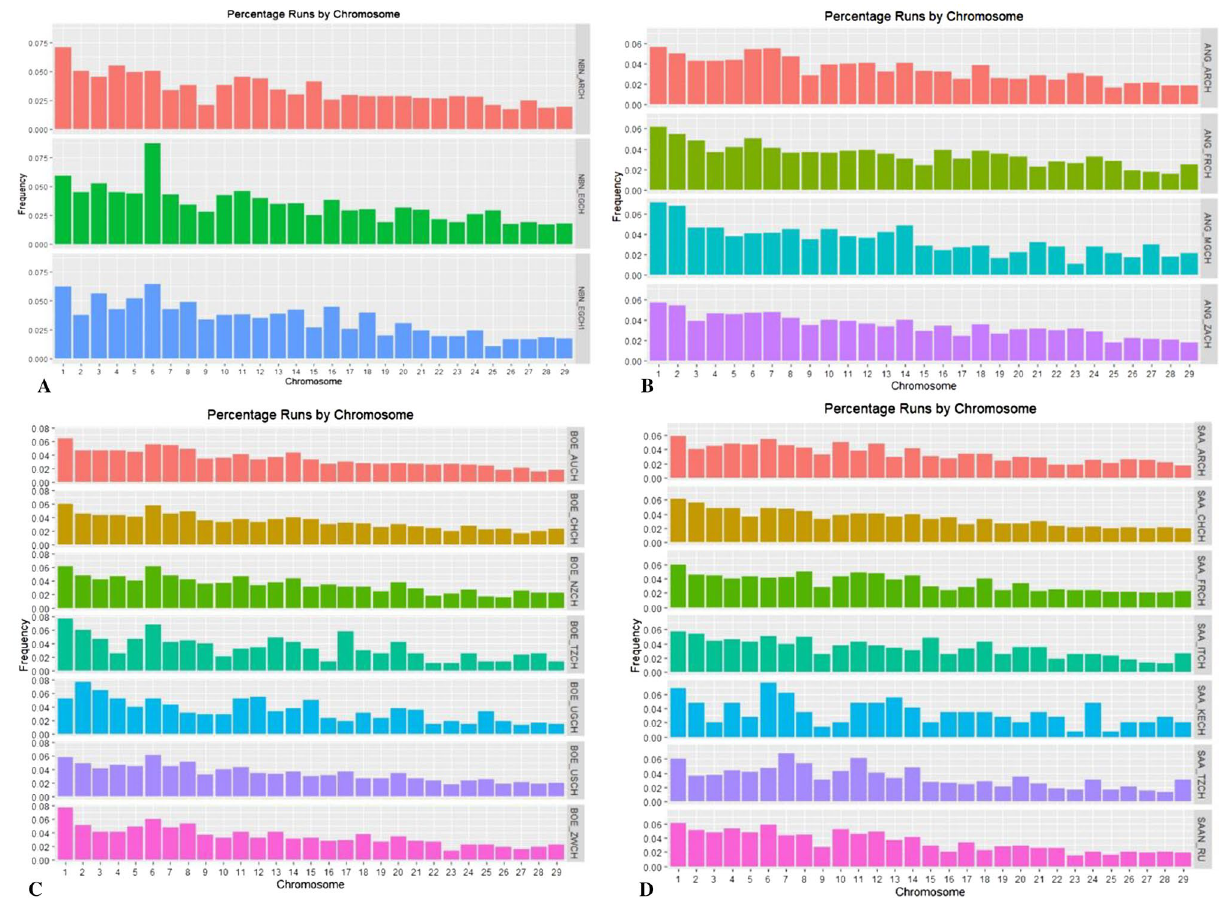
Figure 5. Percentage of Runs Of Homozygosity. The bars exhibit the frequency of ROH per chromosome identified in every population for the four breeds. A different colour is assigned to each population within every breed. A = Nubian, B = Angora, C = Boer and D =